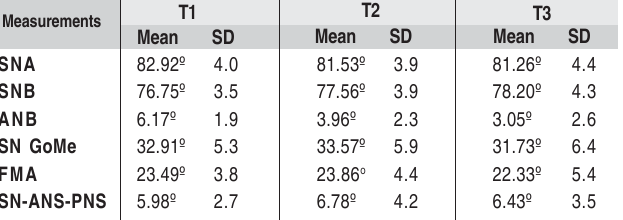
Table 2 - Sagittal and vertical angular cephalometric